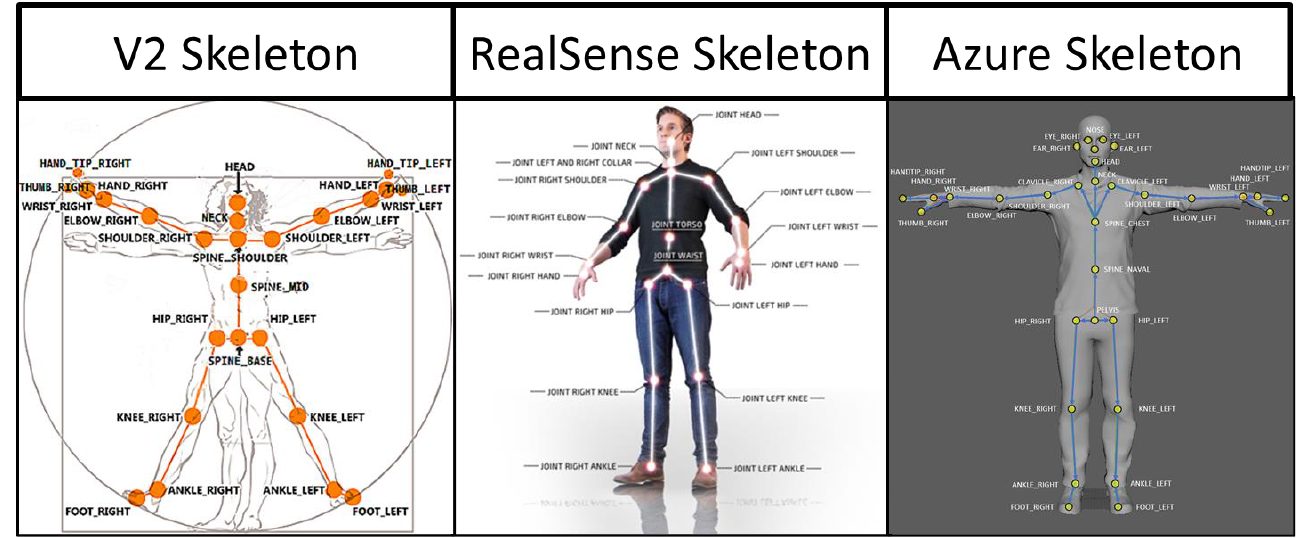
Figure 3. Skeletal joint center maps for each sensor.